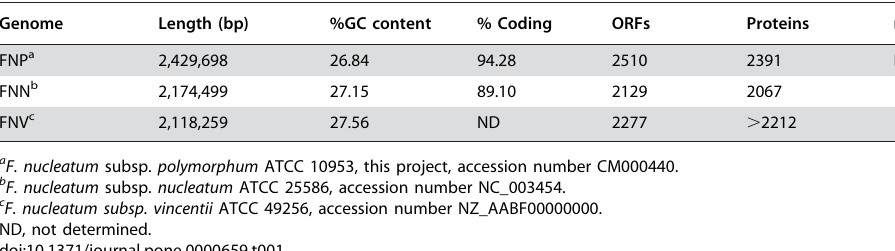
Table 1. General genome statistics for FNP, FNN and FNV. .. ... .... ... ... .... ... ... .... ... ... .... ... ... .... ... ... .... ... ... .... ... ... .... ... ... .... ... ... .... ... ... .... ... ... .... ... ... .... ... ... .... ... ... .